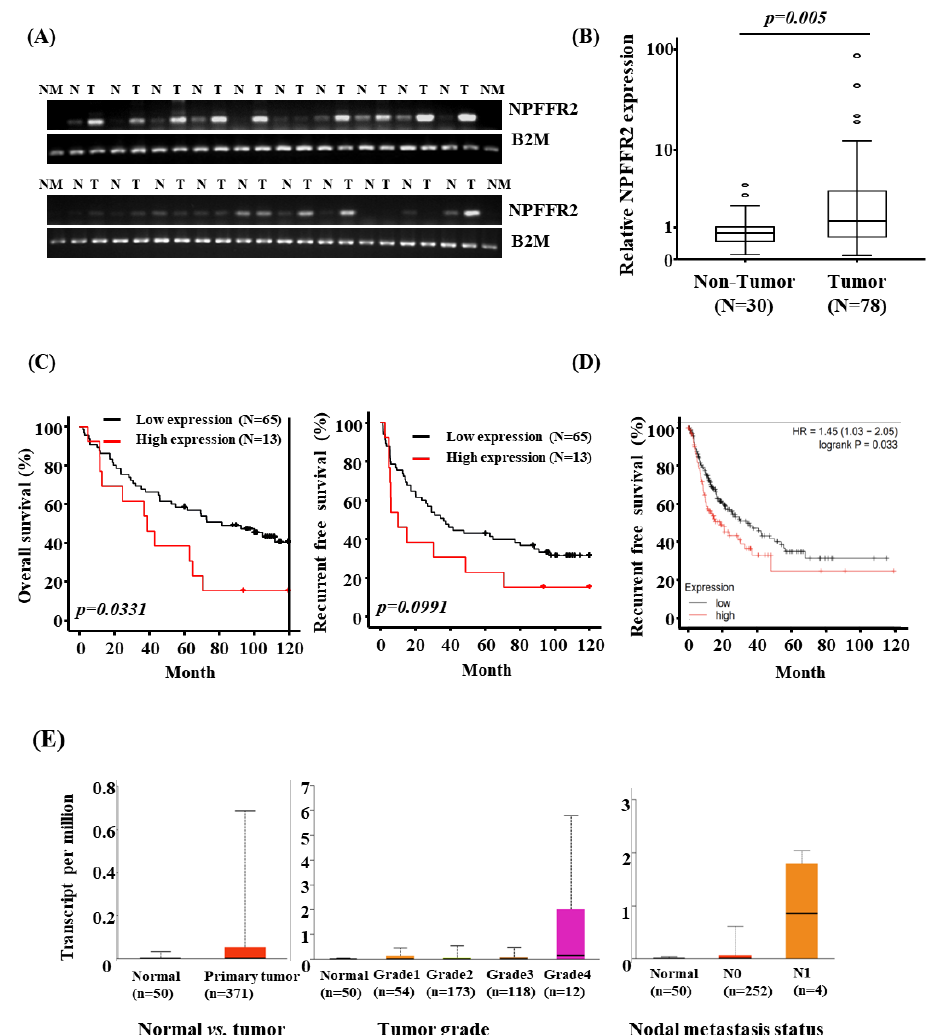
Figure 1. Analysis of NPFFR2 expression in HCC tissues. ( A ) NPFFR2 mRNA expression was compared in HCC (T, tumor) and adjacent liver tissues (N, non–tumor) using semi–quantitative RT – PCR. ( B ) Boxplot analysis depicting increased NPFFR2 expression in HCC tissues (n = 78) compared with adjacent liver tissues (n = 28). Values deviating from the quartile groups were individually marked with dots. ( C ) Kaplan – Meier survival analysis for NPFFR2 expression in (78) HCC patients (n = 78, low expression, black line < 4.43 –fold and high expression, red line ≥ 4.43– fold). ( D ) Comparison of expressions by recurrence – free survival analysis. Recurrence – free survival curves of NPFFR2 were analyzed from the Kaplan – Meier plotter using mRNA sequencing data of HCC (n = 312) in TCGA dataset. ( E ) The relative expression of NPFFR2 in normal tissues and tumor subgroups was analyzed from TCGA dataset using the UALCAN platform. NPFFR2 expression was compared in normal and cancerous tissues ( left ), across tumor grades ( middle ), and between the presence or absence of nodal metastasis ( right ) from TCGA data using the UALCAN platform.